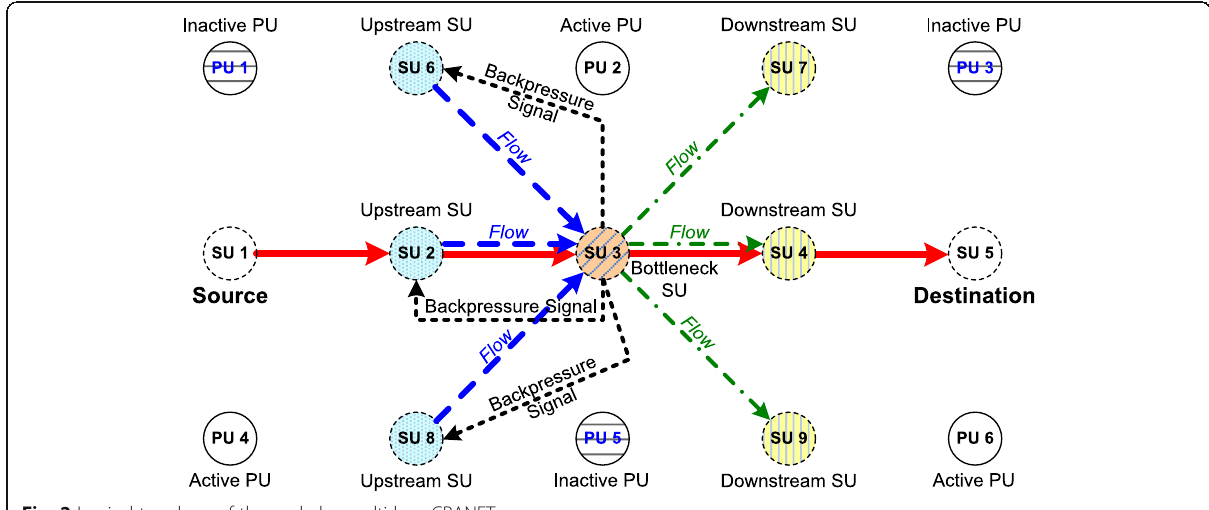
Fig. 2 Logical topology of the underlay multi-hop